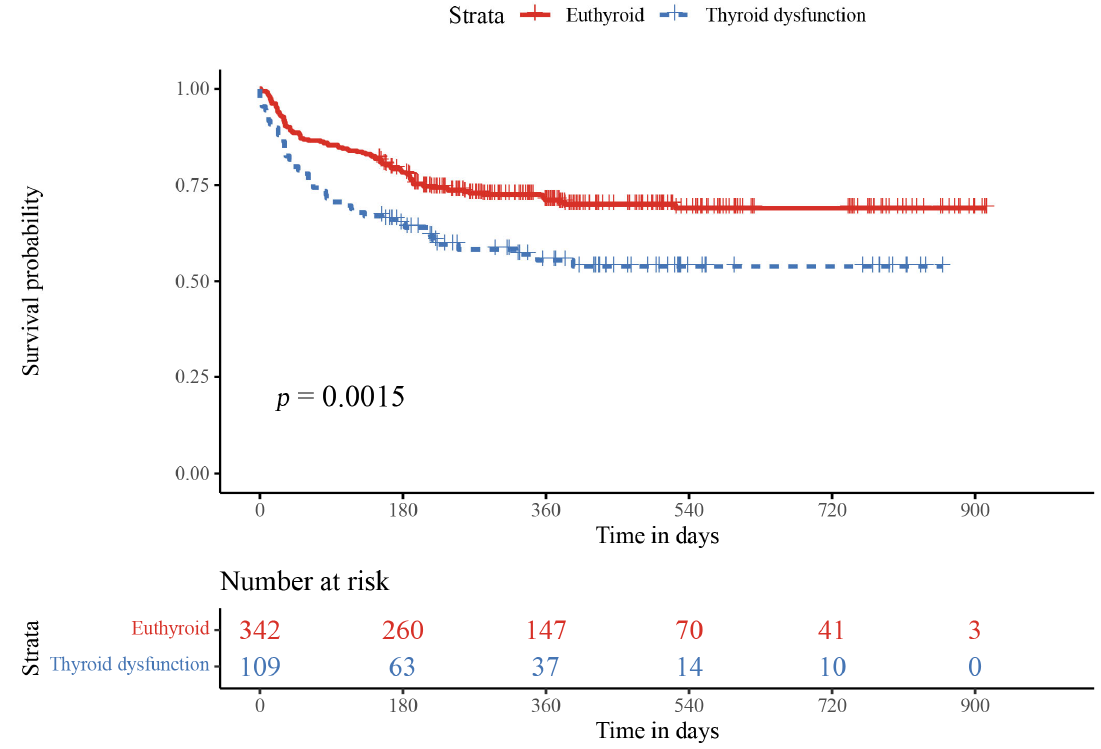
Figure 3. Kaplan–Meier survival curves for thyroid dysfunction compared with the euthytoidism group. Survival probability rate based on the thyroid function in patients with enrolled subjects. The red line represents the survival probability rate of the euthyroid group, while the blue line represents the thyroid dysfunction group. A significant difference was found between the two groups ( p = 0.0015).